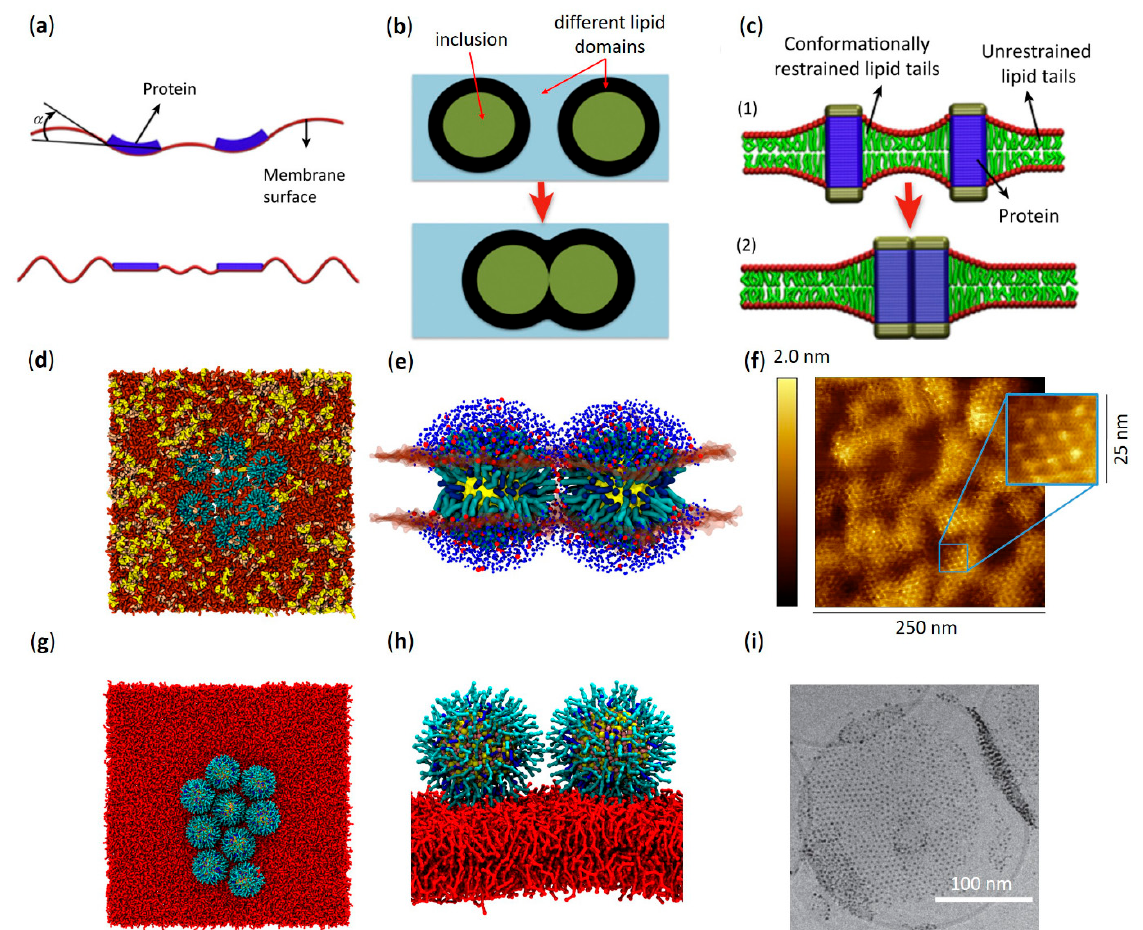
Figure 5. The tendency for membrane aggregation is shared by amphiphilic AuNPs and amphiphilic peptides. ( a ) Top, sketch of two curvature inducing membrane inclusions; due to the elastic energy of the membrane, an effective interacting potential can arise and, depending on the system, the interaction can be attractive and thus lead to aggregation. Bottom, system in which the inclusions suppress the natural fluctuations of the membrane; aggregation can minimize this region. ( b ) Aggregation induced by lipid depletion. ( c ) Aggregation induced by capillary forces. In configuration (1), there are two regions of modified lipid density around the inclusion; dimerization allows to minimize their total area, as shown in configuration (2). ( d ) Ordered aggregate of MUS:OT NPs adsorbed on a DOPC membrane. The snapshot is taken from unbiased MD simulations (Martini CG). Nanoparticles are represented with yellow beads (Au), pink beads (S), cyan (MUS ligands) and blue (OT ligands); membrane lipids are represented with red beads. ( e ) Dimer of adsorbed NPs on